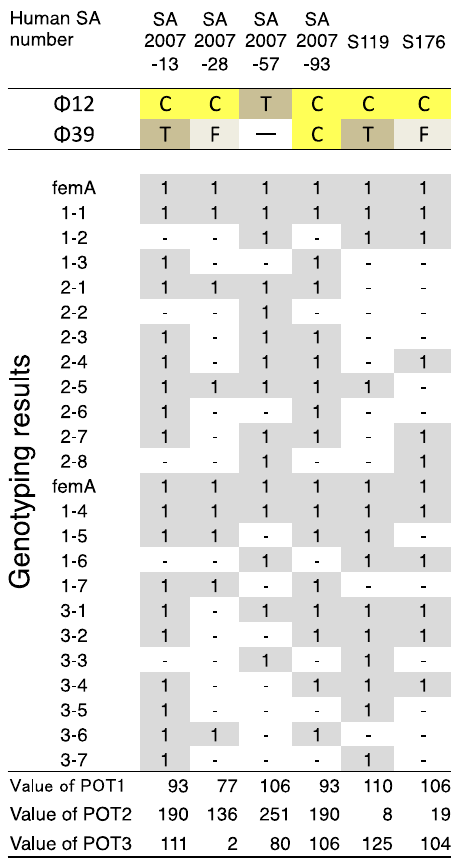
Table 3. Host ranges of S. aureus phages, Φ SA012 and Φ SA039, against S. aureus methicillin-resistant S. aureus (MRSA) strains.